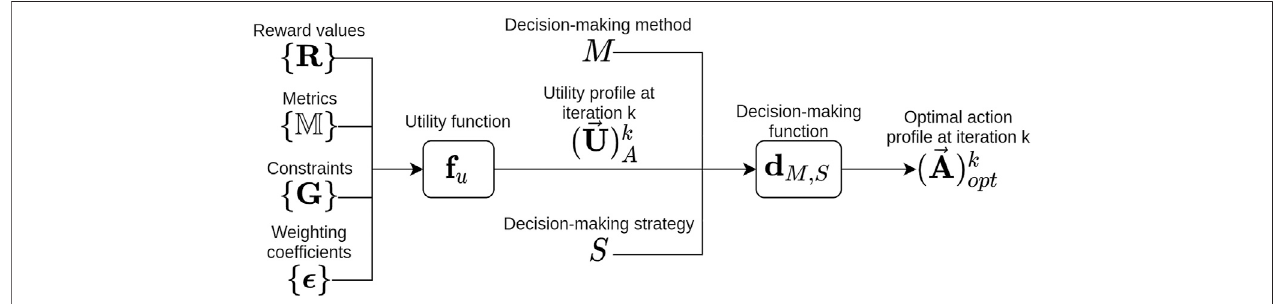
FIGURE 2 | Block diagram of our formalization of the decision-making process used to calculate the optimal action pro fi le ( (cid:2) A ) k opt at iteration k